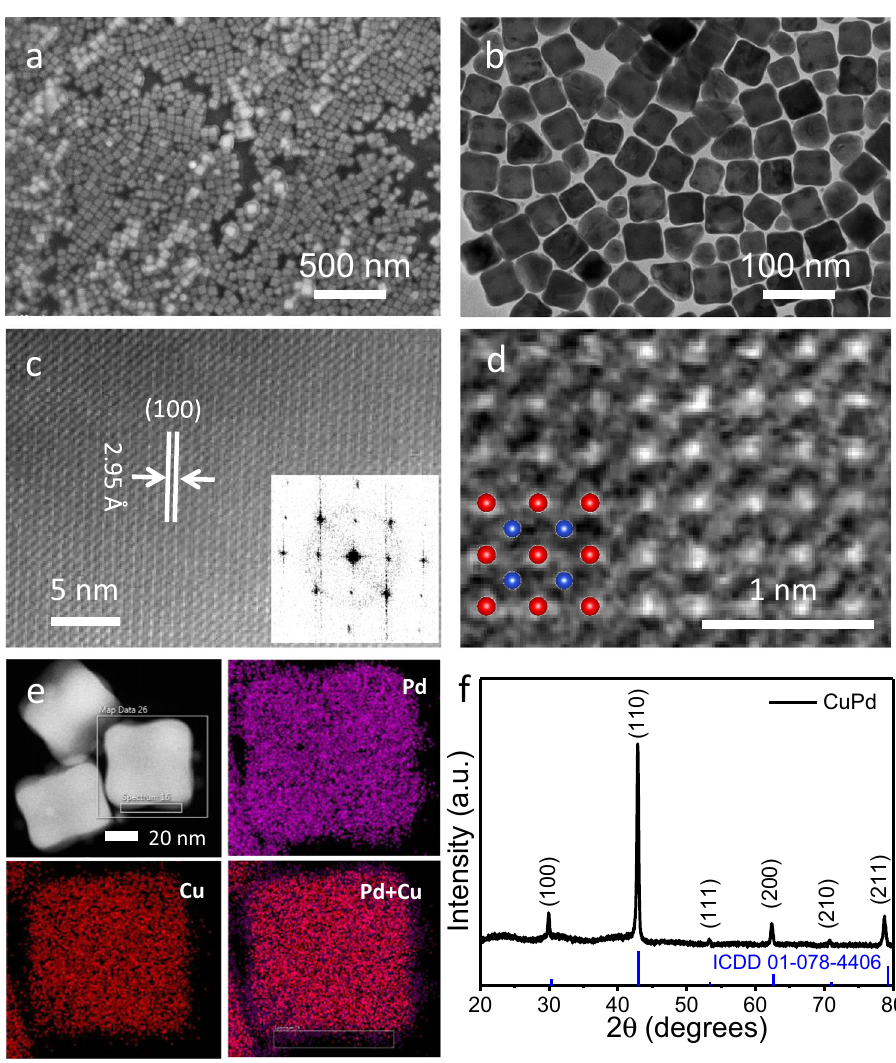
Fig. 3 Characterizations of the B2-ordered intermetallic CuPd nanocubes. a An SEM secondary-electron image, b A TEM BF image, and c An HAADF- STEM image of the as-synthesized ordered CuPd nanocubes. Inset shows the corresponding Fourier-transform (FT) pattern of the CuPd nanocube. d An HAADF-STEM image with a zoomed-in view of the ordered CuPd nanocube. Blue and red balls in the overlaid model correspond to Cu and Pd atoms, respectively. e X-EDS elemental maps and the corresponding HAADF image of the CuPd nanocubes. f The XRD pattern of synthesized ordered CuPd